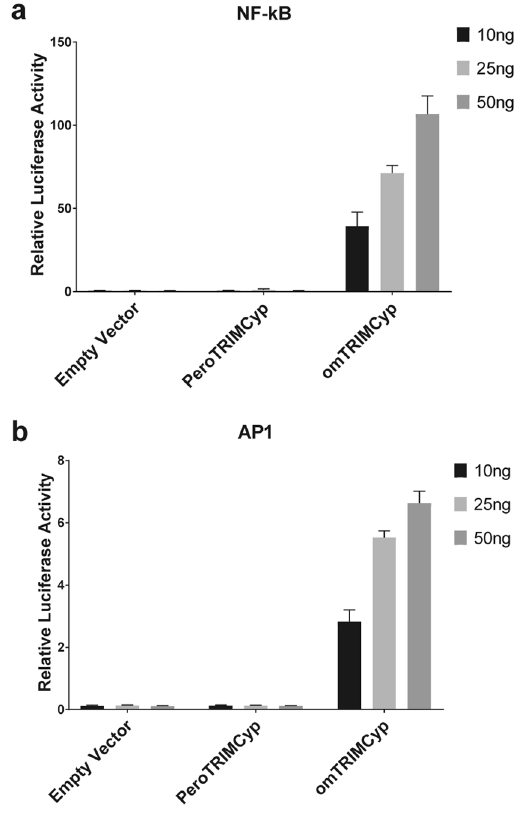
Figure 8. Ectopic expression of peroTRIMCyp does not activate Nf- κ B or AP-1 signaling. HEK293T cells were co-transfected with the indicated amounts of omTRIMCyp, peroTRIMCyp or empty vector together with luciferase reporter plasmids containing either ( a ) Nf- κ B or ( b ) AP-1 promoters. 20 ng of pRL-TK was added to determine transfection efficiency. Values shown represent firefly luciferase readings normalized to Renilla luciferase. Error bars indicate standard deviation. Values represent average of 3 independent